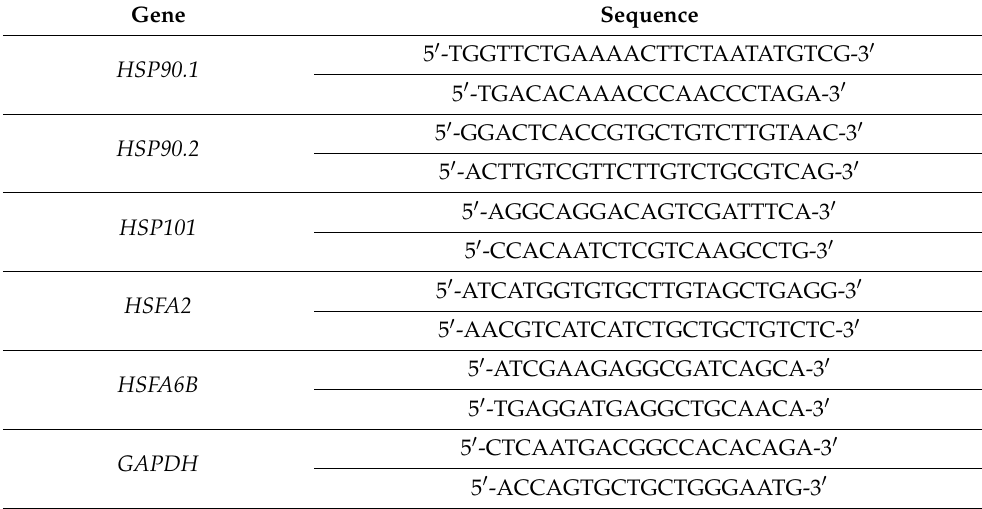
Table 1. Cont. Gene